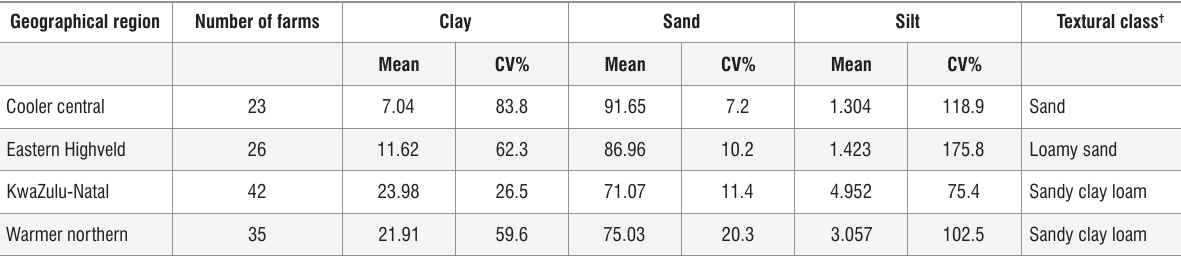
CV, coefficient of